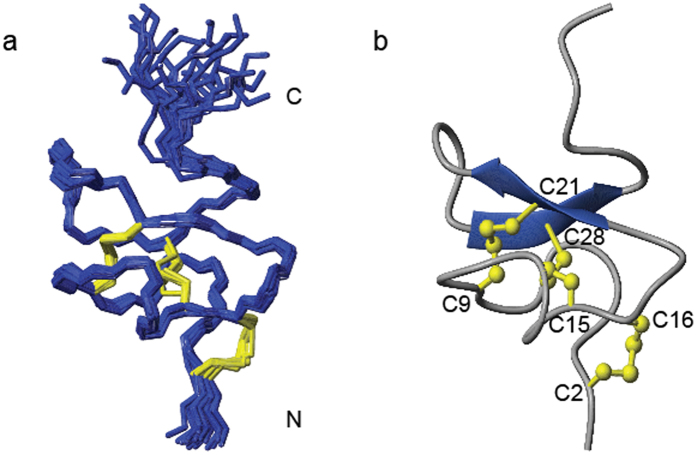
Solution structure of Pn3a.(a) The family of the 20 lowest energy structures superimposed over the backbone with disulfide bonds shown in yellow (Protein Data Bank code 5T4R). (b) The lowest energy structure with β-strands shown as arrows and disulfide bonds in ball and stick representation.